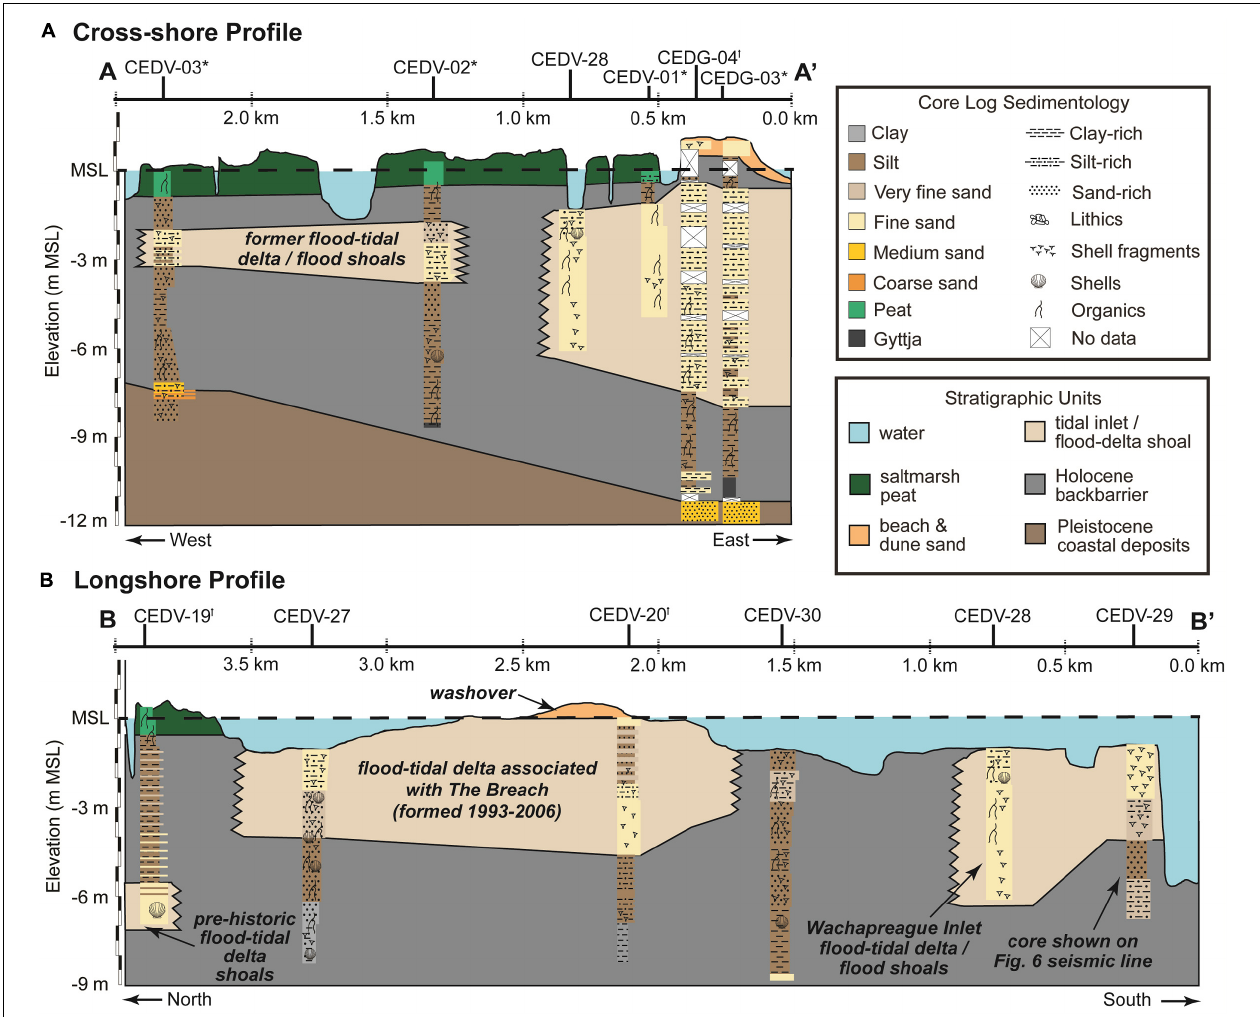
FIGURE 7 | Stratigraphic sections developed from cores collected along (A) shore-normal and (B) shore-parallel transects west (landward) of southern Cedar Island (see location, Figure 4 ). Cores targeted the project site (CEDV-20, CEDV-27), flood-delta shoals (target borrow sites) (CEDV-28, CEDV-29), and reference island (CEDG-03, CEDG-04) and saltmarsh (e.g., CEDV-19, CEDV-02) locations. Core logs denoted with an asterisk (*) were originally published by Shawler et al. (2019); those denoted with a dagger ( † ) were originally published by Shawler et al.